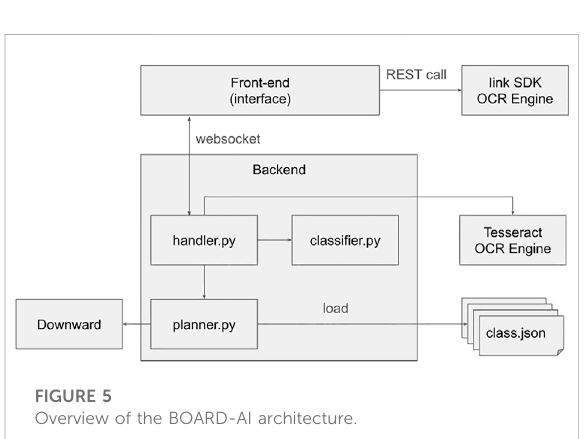
FIGURE 5 Overview of the BOARD-AI